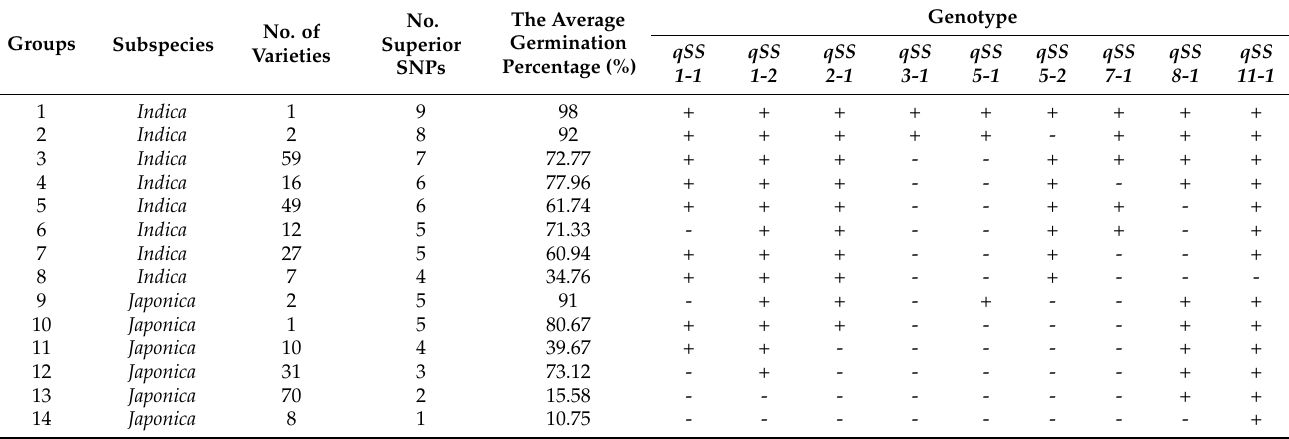
Table 3. The main haplotype analysis of the nine QTLs for seed storability in the whole population (+ superior SNP, − inferior